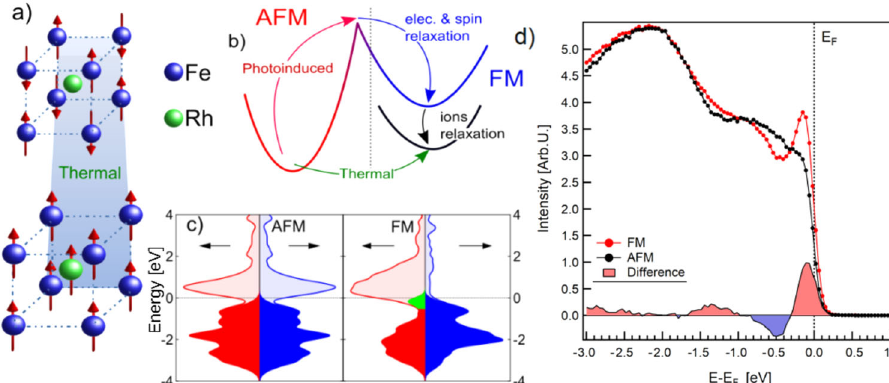
Fig. 1 Electronic properties of FeRh across the metamagnetic phase transition. a Sketch of the isostructural metamagnetic phase transition in FeRh. At room temperature (top) the system is AFM showing atomic magnetic moments only at the Fe atom sites ( m Fe = ±3.3 μ B ). Above 360 K (bottom) the system has ferromagnetically coupled magnetic moments at the Fe ( m Fe = 3.1 μ B ) and Rh ( m Rh = 0.9 μ B ) sites. The whole unit cell expands isotropically by about 1% in volume 69 . b Schematic representation of the two possible paths in the AFM to FM phase transition: direct thermally-driven transition to the FM phase (green arrow), and two-step transition going through a transient electronic state reached during photoexcitation (red arrow) followed by relaxation to the equilibrium FM state (blue and black arrows). c Calculated spin-resolved electronic density of states in the AFM and FM phases. The fi lled areas represent the electronic occupation at thermal equilibrium, with the green area highlighting the position of the Fe minority band (see manuscript text). d Measured x-ray photoelectron spectra of FeRh in the AFM (black dots) and FM (red dots) phase. The solid curve at the bottom of the graph is the difference between the two spectra, which allows to appreciate the relative electron density change across the transition. The data correspond to quasi- static thermal cycling experiments prior to the time-resolved